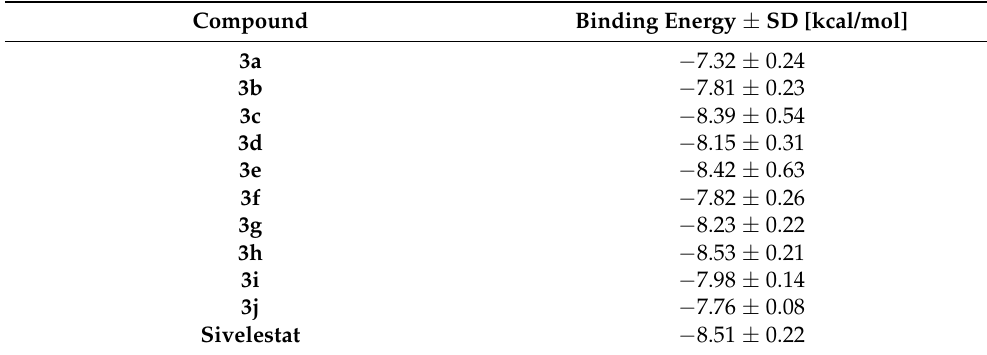
Table 2. The docking results with respect to the studied ligands. The calculations were averaged over the five structures available in the PDB database; the corresponding standard deviations are given as